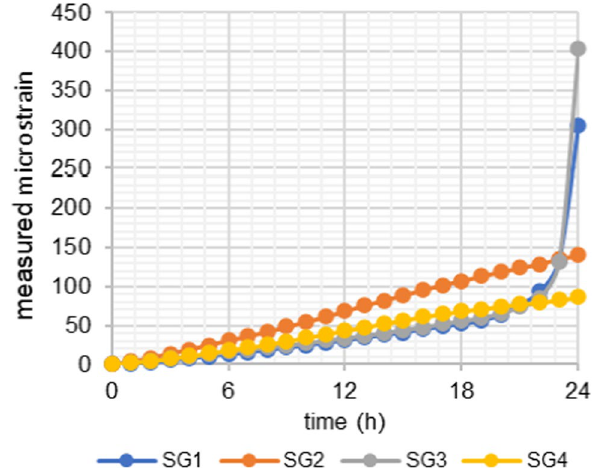
Fig. 8 Measured strains in specimen